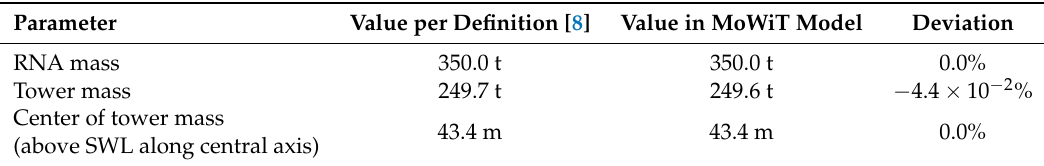
Table 4. Mass-related properties of the OC3 turbine, prescribed values in comparison with the model